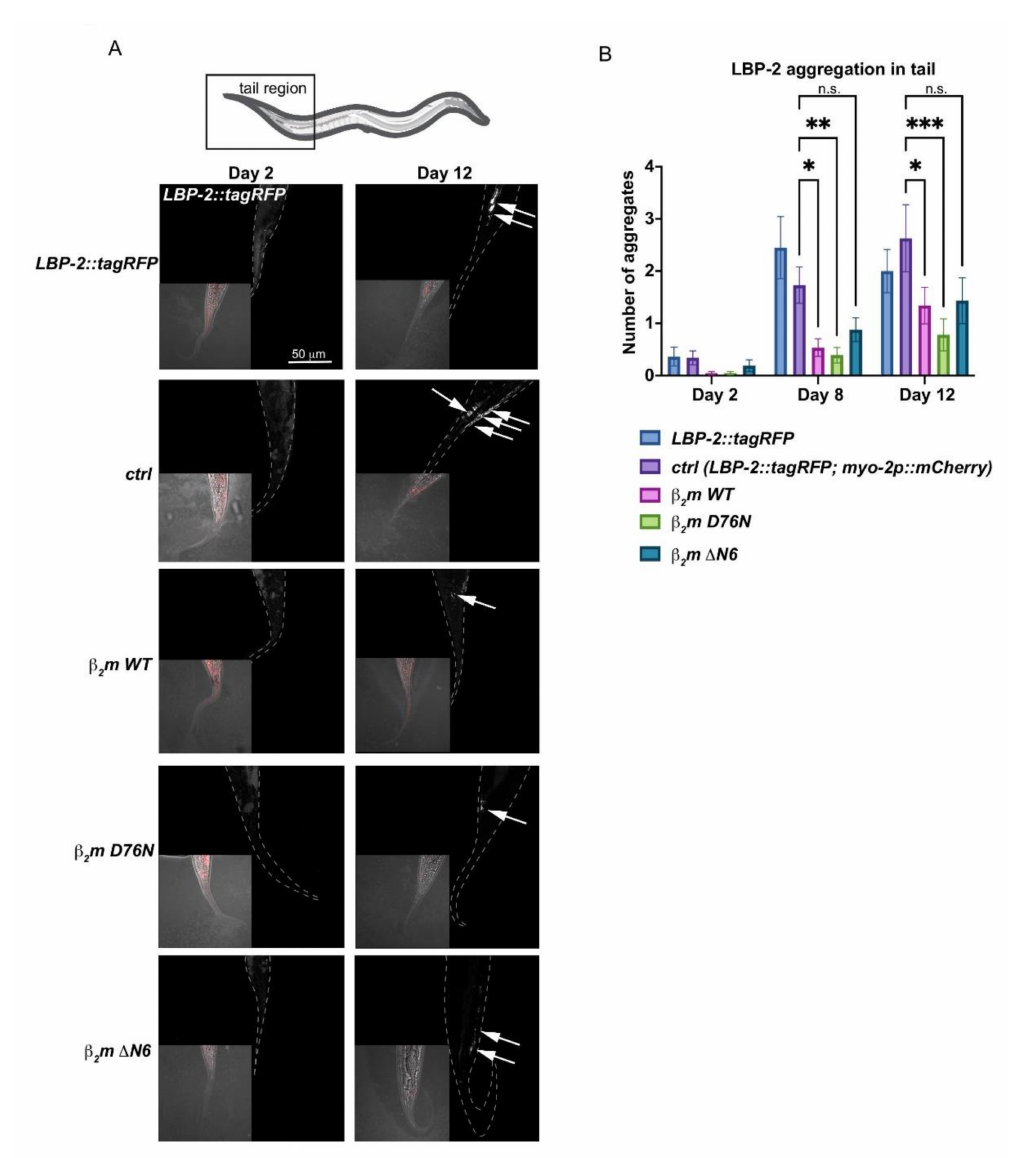
Figure 5. LBP-2 aggregation is reduced in β 2 m expressing nematodes. ( A ) LBP-2::tagRFP puncta in the tail region of day 2 and day 12 adults. Maximum projection is shown. Scale bar, 50 µ m. Aggregates are indicated by white arrows. ( B ) Quantification of LBP-2::tagRFP aggregation with age (day 2, day 8, day 12) in β 2 m expressing nematodes compared to control strains. Two independent experiments were performed for each strain ( n = 10–21 worms per condition per experiment); error bars indicate S.E.M. P-values were determined by a two-way ANOVA followed by a post-hoc Tukey’s test for day 8 and day 12 relative to the ctrl strain (expressing the myo-2p::mCherry co-injection marker). * p < 0.05; ** p < 0.01; *** p < 0.001; n.s. = not